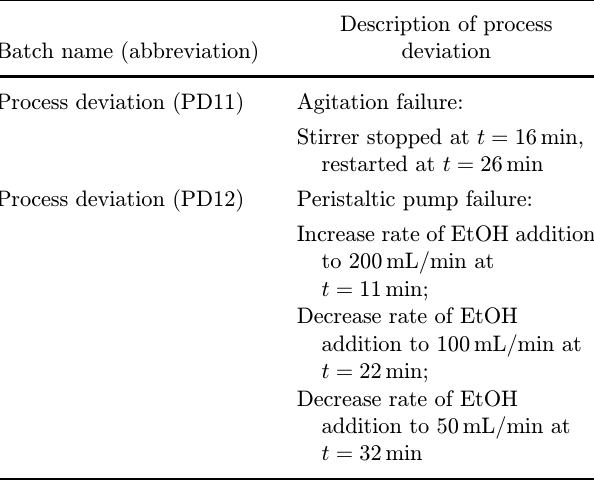
Table 2. Process disturbances introduced to batches PD10 and